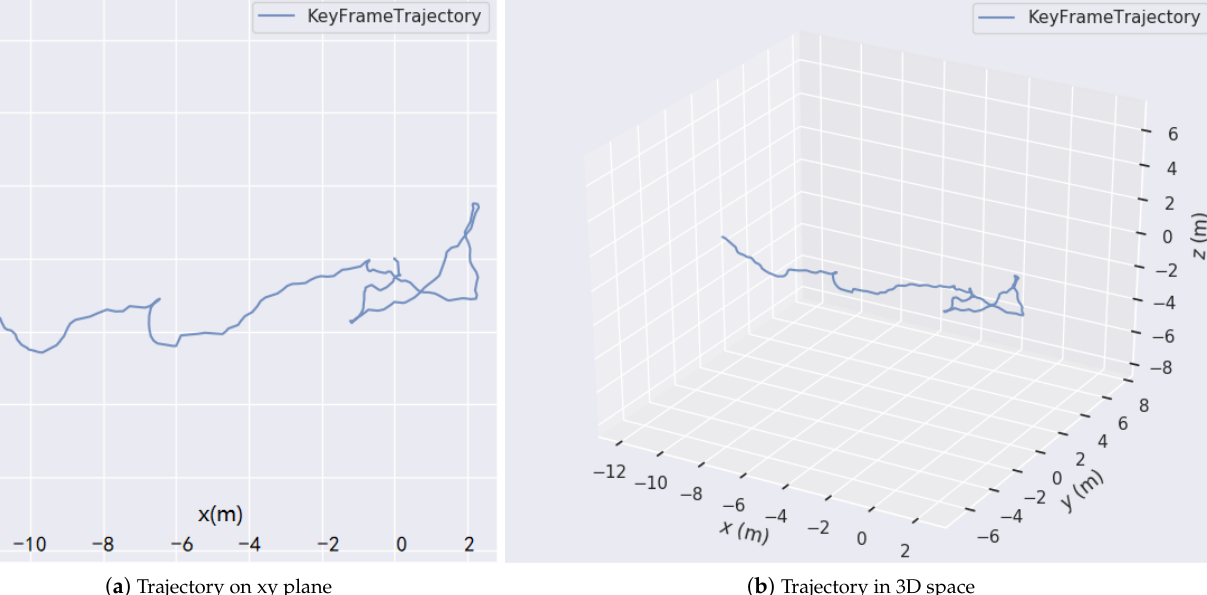
Figure 10. The estimated trajectories in 2D/3D space. Note: the mapping system only uses key frames for reconstruction, so only the trajectories of key frames on the xy plane and in 3D space are